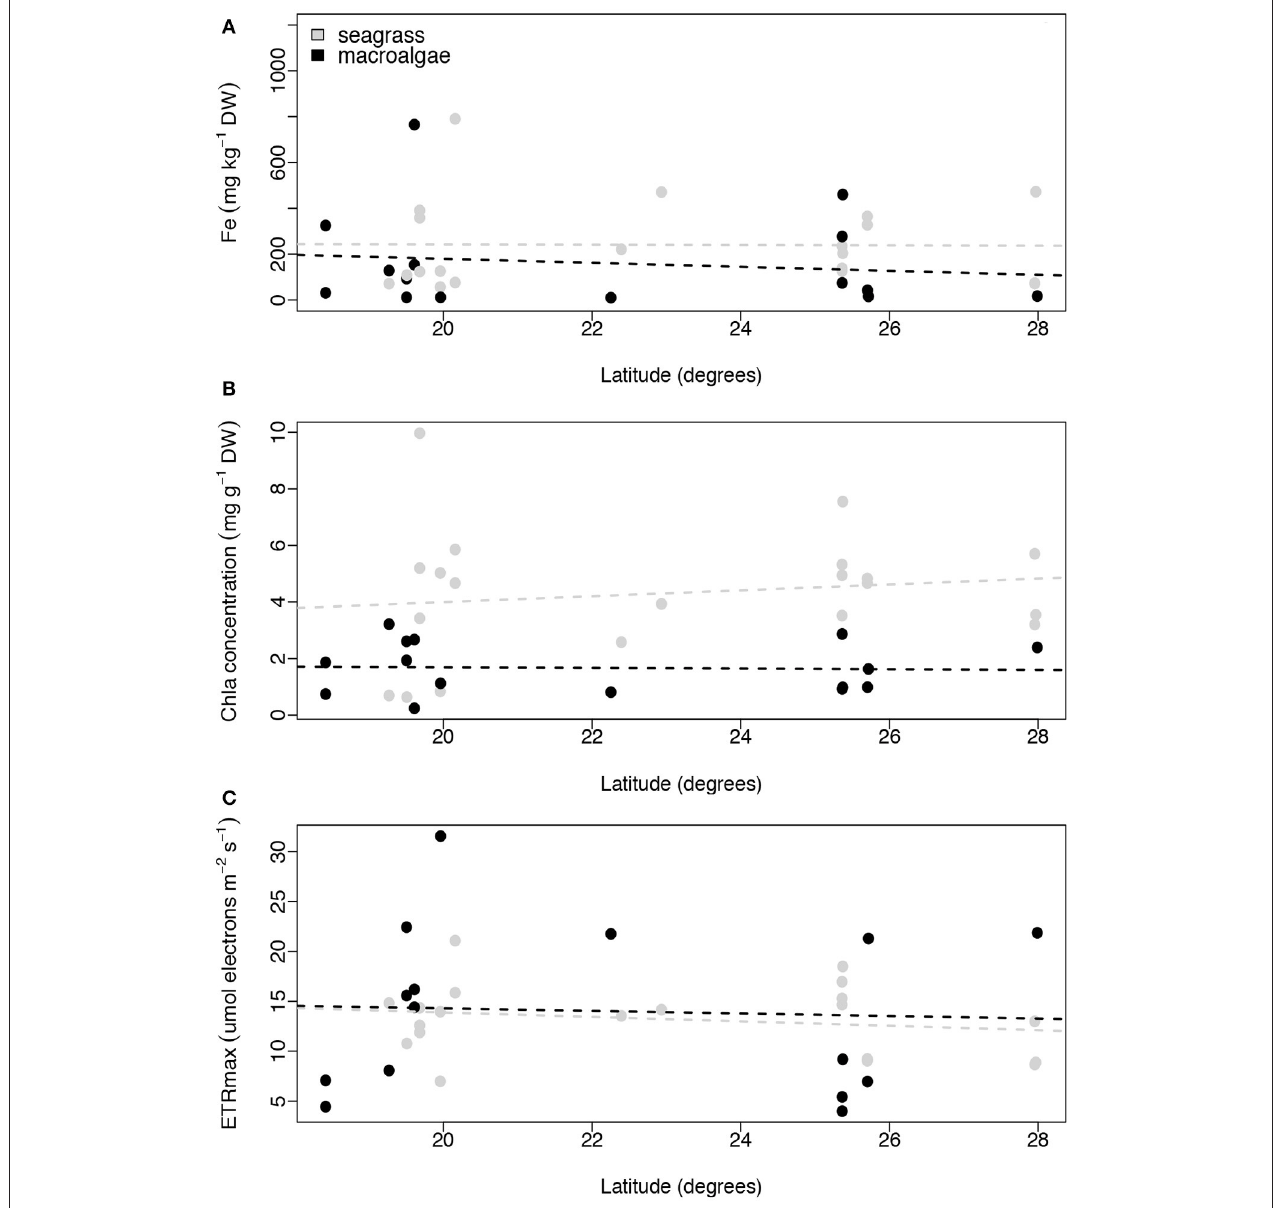
FIGURE 6 | Relationships between latitude (degrees) and average iron concentration (mg kg − 1 DW; A ), average Chl a concentration (mg g − 1 DW, B ), and average ETRmax ( µ mol electrons m − 2 s − 1 ; C ) per species per site. Non-significant regressions are indicated with a dash line. The number of replicates is indicated in Table 2 .